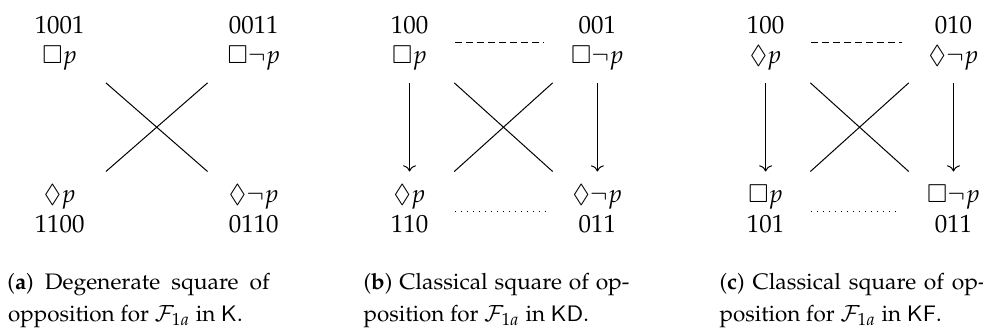
Figure 3. Aristotelian diagrams for F 1 a : = { (cid:3) p , ♦ p , (cid:3) ¬ p , ♦ ¬ p } in three normal modal